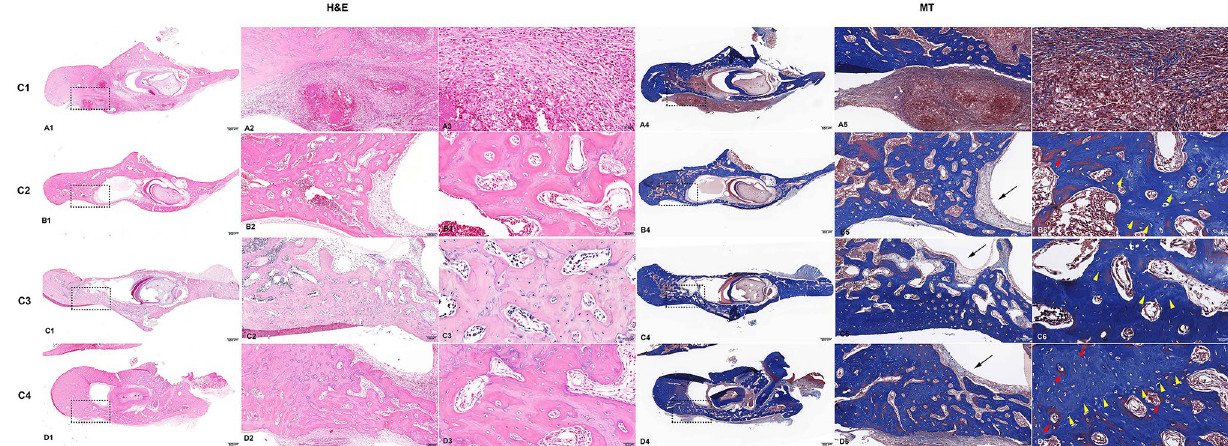
Figure 6. Representative histological images of the specimens following 4 weeks of treatment stained with H&E and MT. In the C1 group, intense inflammatory infiltration is observed, 5.0 × ( A1 ). Magnification of the rectangles, 10 × , 40 × ( A2 – A3 ). MT stain for bone regeneration in the defect area ( A4 ). Magnification of the rectangles, 10 × , 40 × ( A5 – A6 ). The C2 group showed bone healing with osteoblastic cell lining in the parenchymal tissue found at the center of the defect area with evidence of inflammatory infiltrates ( B1 ). Magnification of the rectangles, 10 × , 4 0 × ( B2 – B3 ). MT stain for bone regeneration in the C2 group at 2 × ( B4 ). Magnification of the rectangles, 10 × , 40 × ( B5 – B6 ). The E1 group showed loose marrow fibrosis and scattered lymphocytic inflammatory infiltrates ( C1 ). High power view of the rectangles, 10 × , 40 × ( C2 , C3 ). The MT stain of E1 group showed new bone formation stained with bright blue color and new blood vessels were observed ( C4 ). Magnification of the rectangles, 10 × , 40 × ( C5 , C6 ). The E2 group showed increased osteophytic bone formation ( D1 ). High power view of the rectangles at 10 × , 40 × ( D2 , D3 ). The E2 group showed active bone remodeling with the thickest compact new bone formation in the defect area compared to that of other groups ( D4 ). An increased number of Haversian canals with osteoblast rimming and new blood vessel formation stained with thick red color by the MT stain were observed at 10 × , 40 × magnification ( D5 , D6 ). Black arrow, parenchymal tissue, Yellow arrowhead, new bone formation, Red arrow, blood vessel formation.